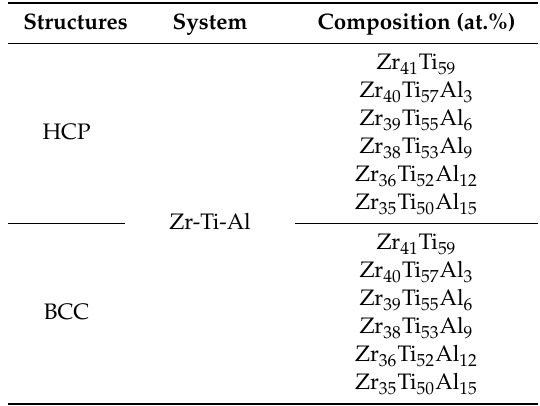
Table 1. Zr-Ti-Al alloy systems in HCP structure and BCC structure with di ff erent atomic fraction of Al.